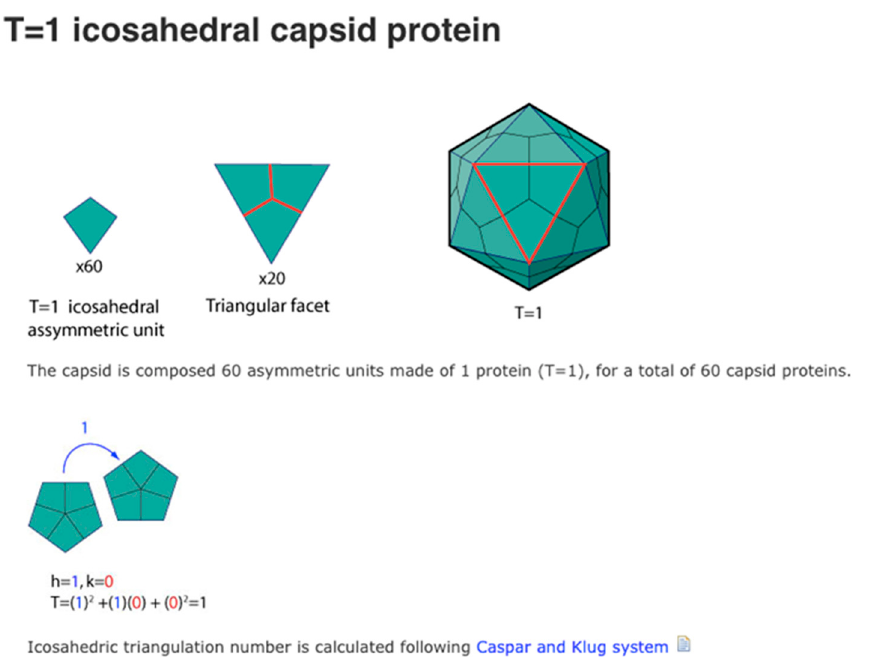
Figure 3. T1 viral capsids have 20 triangular capsomeres made of three rhombic structured protein subunits. Source: Viral Zone, https://viralzone.expasy.org/1057, Swiss Institute of Bioinformatics (accessed on 1 December 2022). Table 2. Combinatorial Explosion of the number of Dürer nets for various